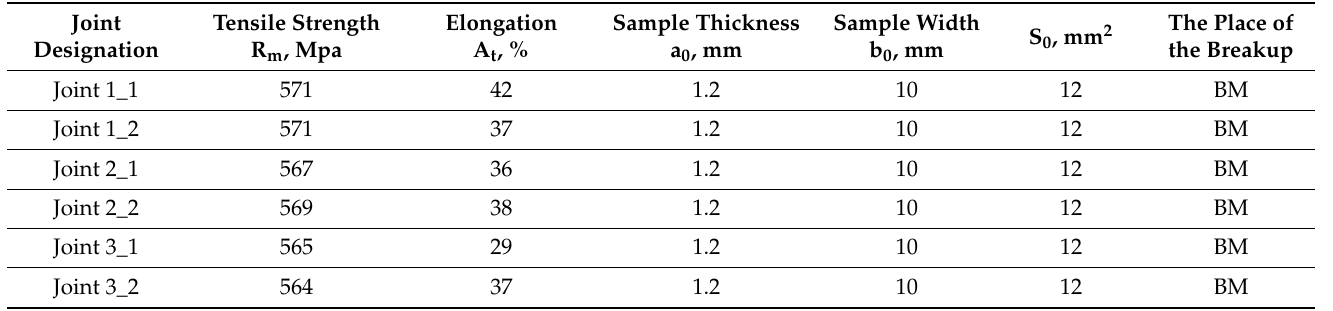
Table 4. Static tensile test results and sample